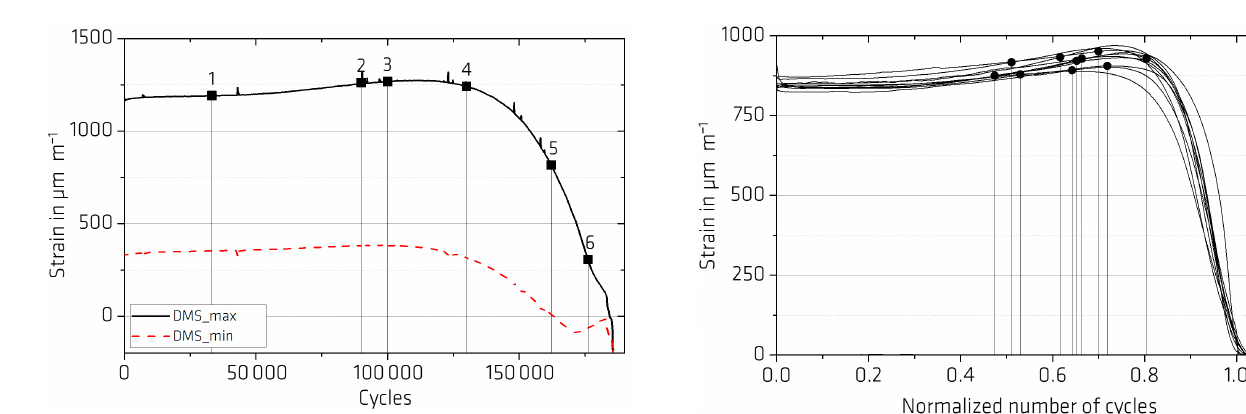
Figure 7. Strain evolution of 10 specimens (metal sheets with notches), each with a marked cycle of crack detection by lumines- cence. The number of cycles was normalized with fracture cycle number on the horizontal axis and strain amplitude on the vertical